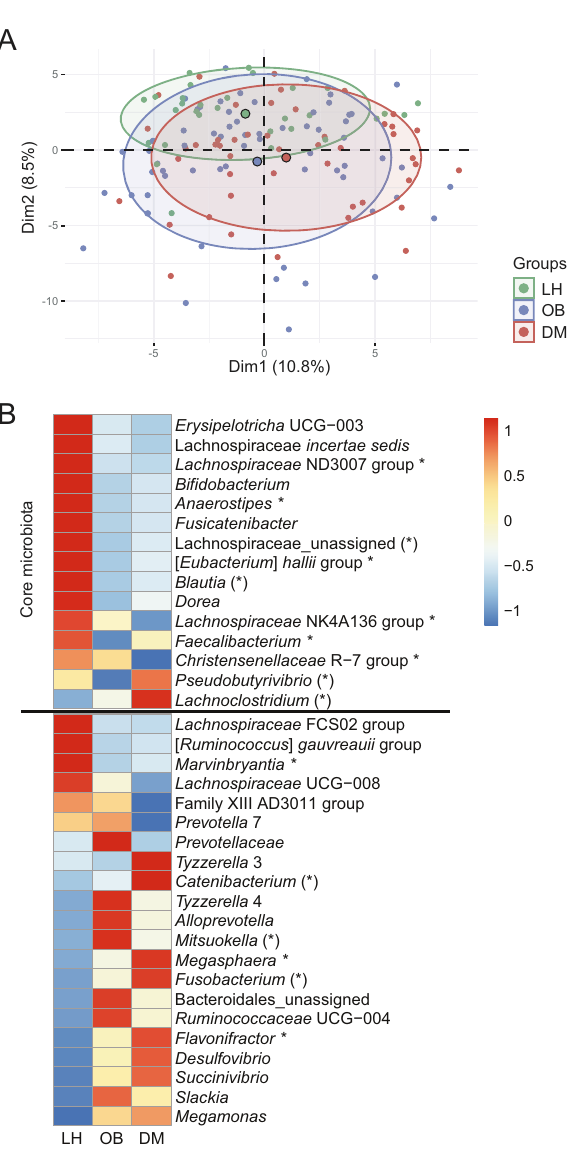
Fig. 1 Fecal microbiome composition. A 2D PCA scores plot on genera level after clr transformation. The explained variance of each component is included in the axis labels. The large points represent the centroids of each group. B Abundances of all signi fi cant genera (FDR <0.1). Proportional data were used. Each cell then represents the mean in each group for the corresponding genera. Rows were z-scaled. Core genera are de fi ned by the condition abundance >0.05% and prevalence >75% at least in one group. Genera marked by * are con fi rmed butyrate producers, and genera marked by (*) are potential butyrate producers.